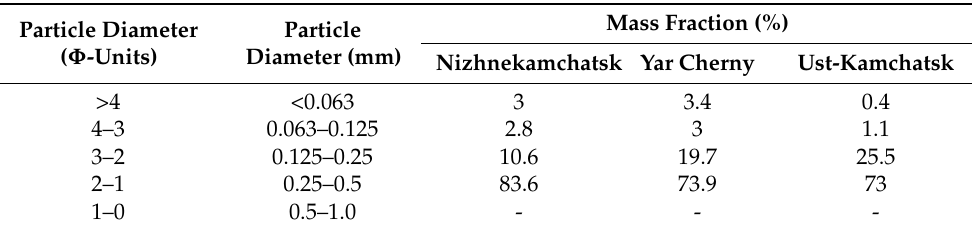
Table 5. Grain-size composition of ash from the Sheveluch volcano eruption in 1964. Data is partially taken from [35] and